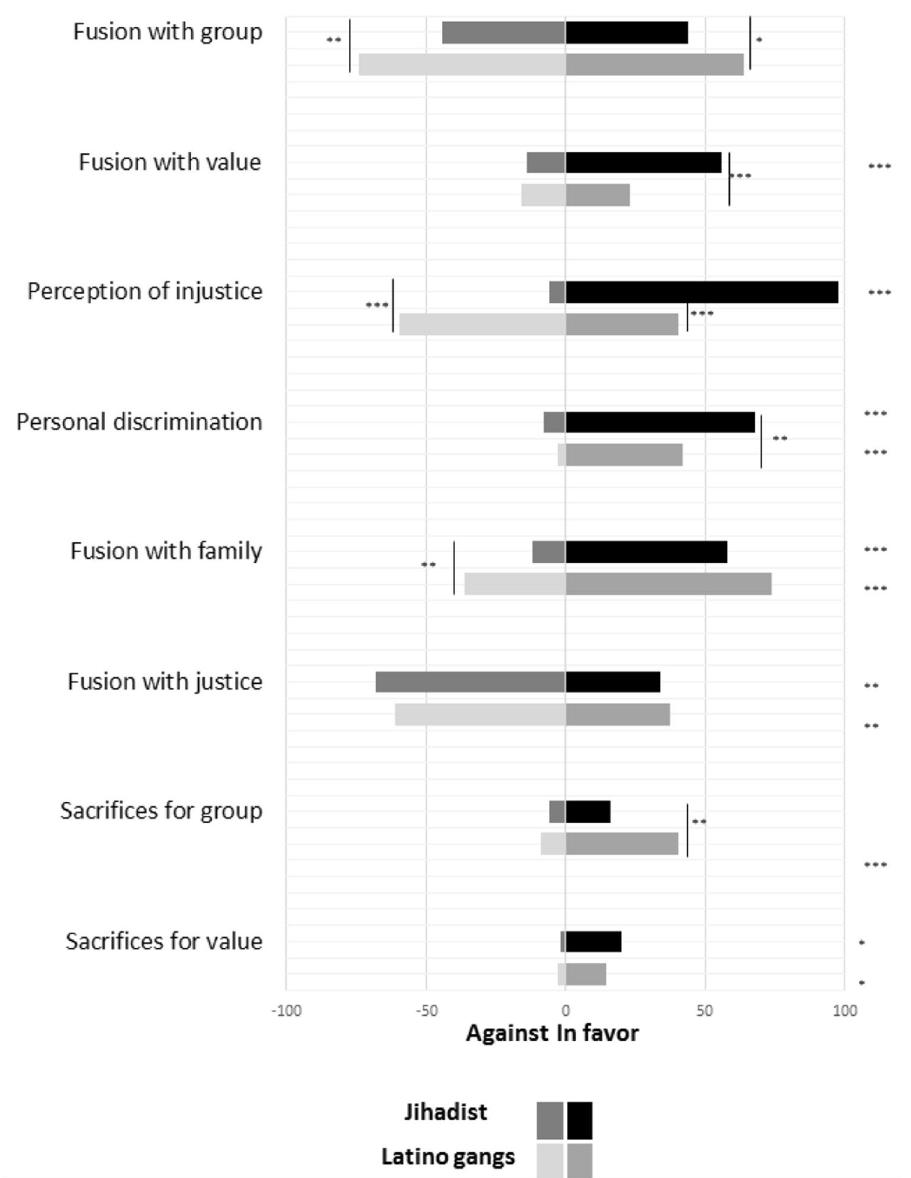
Figure 1. Percentage of jihadists versus Latino gang members providing at least one thematic confirmation for each of eight analytic categories. Right columns represent percentages of prisoners reporting judgements in favor of each category (e.g., high fusion with group); left columns represent percentages of prisoners reporting judgements against each category (e.g., low fusion with group). Asterisks inside the figure indicate significant differences between jihadists and gangs (in displaying more judgements of the category). Asterisks to the right of the figure indicate significant differences within each group (displaying more judgements in favor or against each analytic category). *** p < .001; ** p < .01; * p <